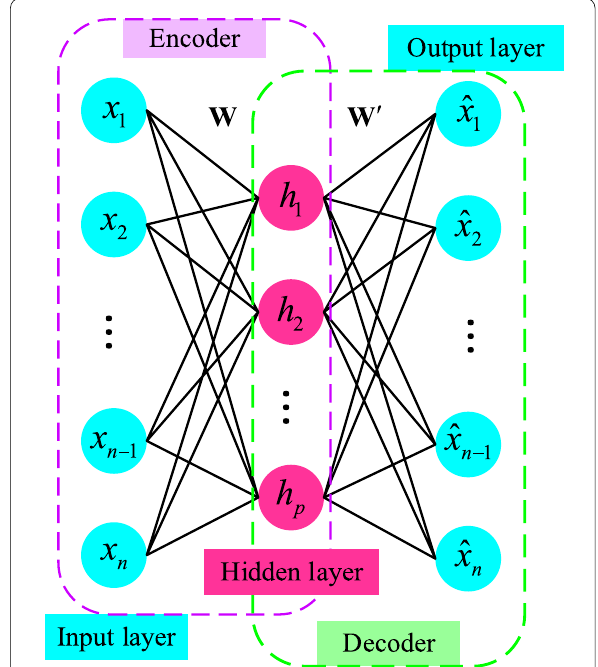
Figure 1 Structure of normal